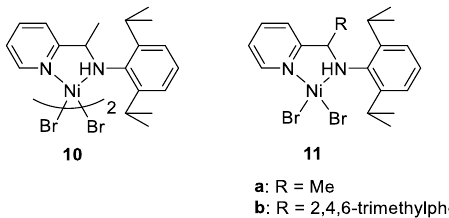
Figure 7. Nickel complexes containing neutral amine – pyridine ligand.